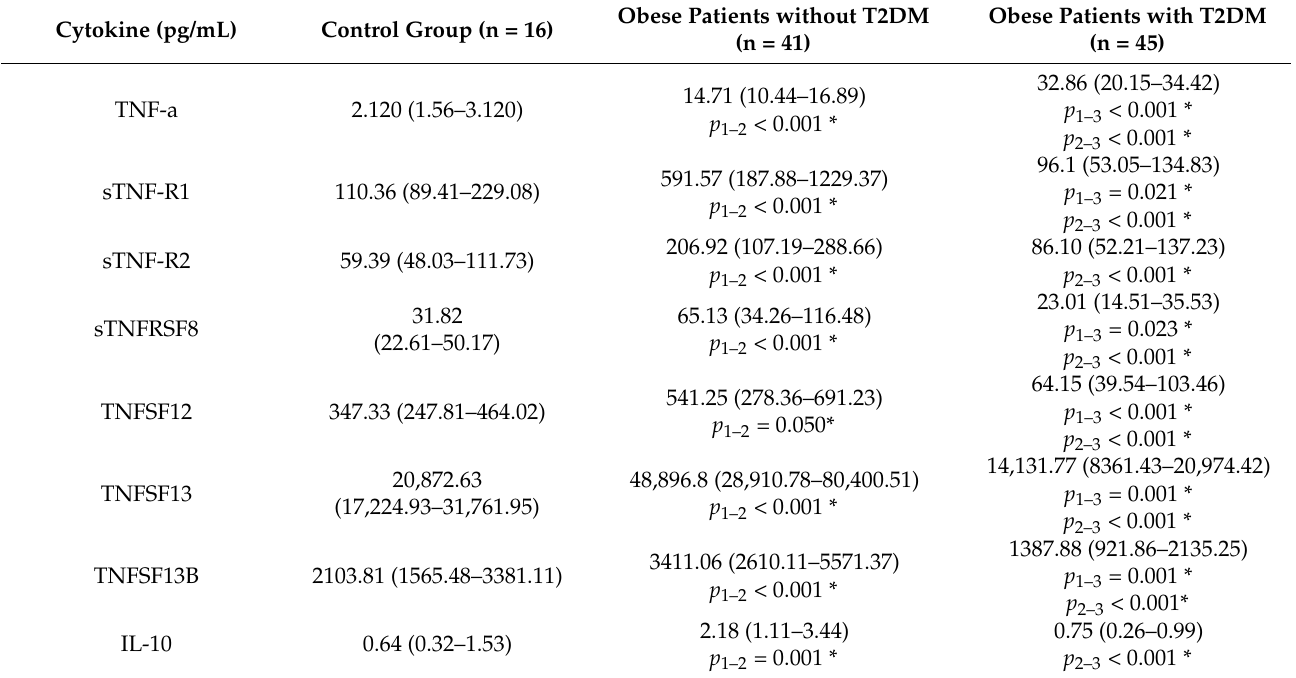
Table 2. The level of pro- and anti-inflammatory cytokines in patients with and without T2DM.